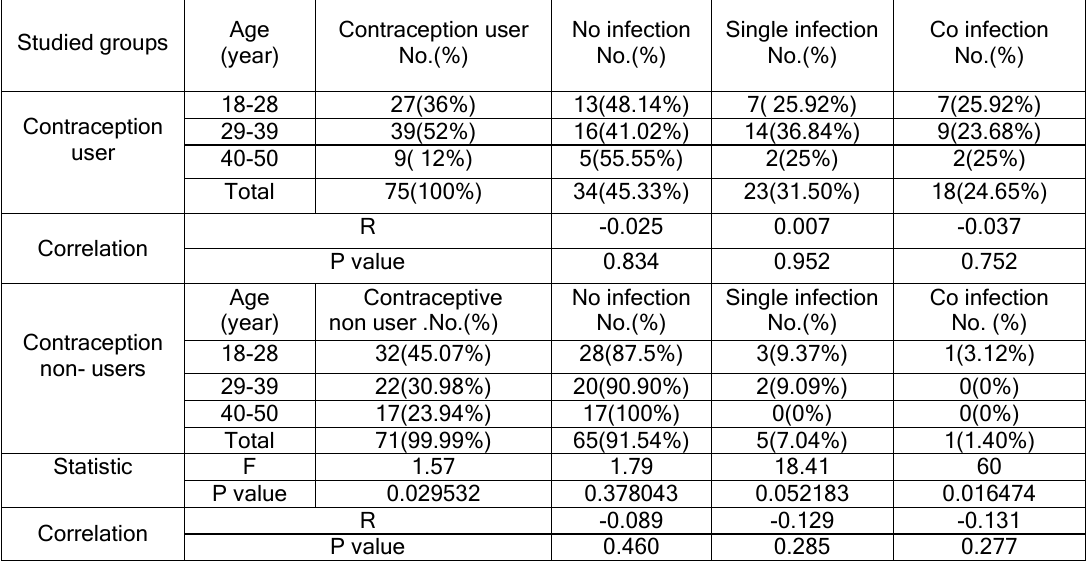
Table (1): Comparison between studied groups regarding infection among different age groups.